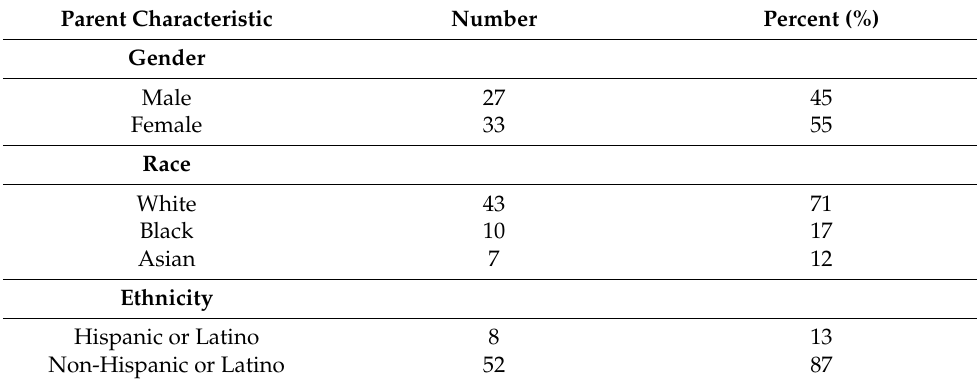
Table 4. Parent Participant